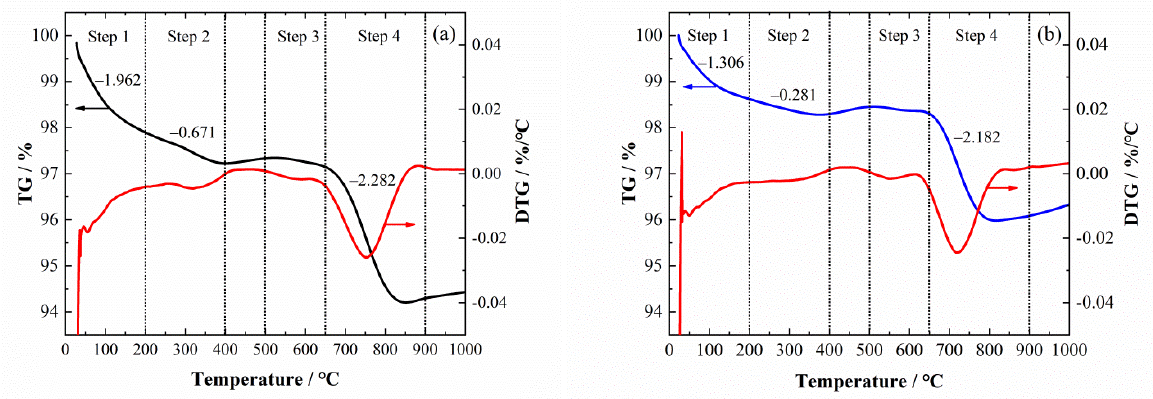
Figure 6. TGA-DTG profiles of FeMn/TiO 2 -S ( a ) and Er 0.05 FeMn/TiO 2 -S ( b )